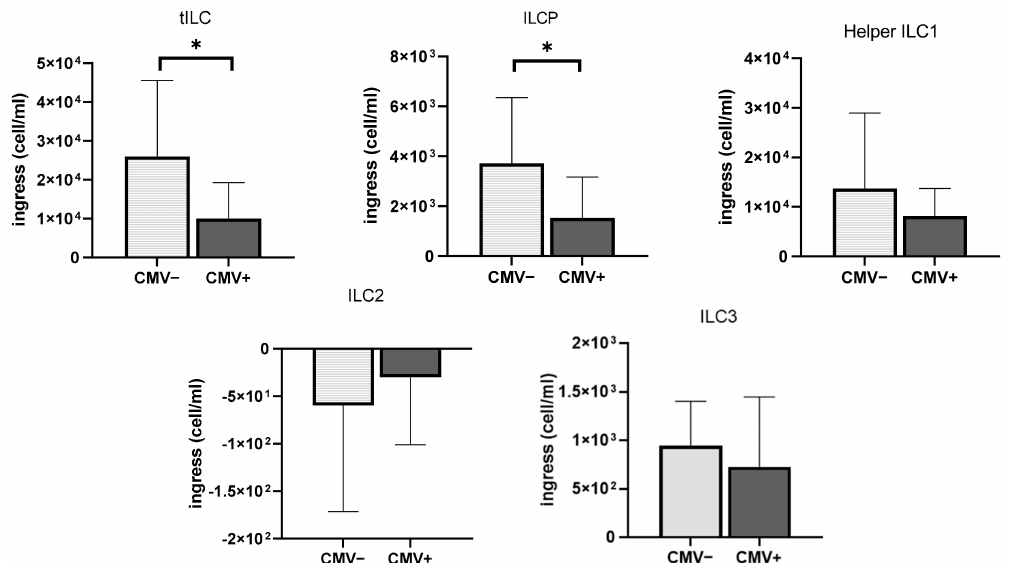
Figure 4. The effect of CMV seropositivity on the mobilization of the different ILC subsets in healthy young adults (n = 22). Changes in ILC counts between resting and post-exercise are represented in light gray for CMV neg participants and in dark gray for CMV pos participants. * Significant differences between CMV pos and CMV neg participants, p < 0.05. Data are mean ±